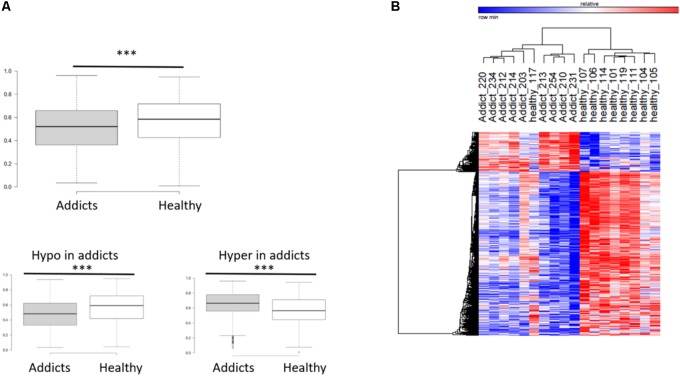
DNA methylation differences associated with addiction. (A) Box plot of average methylation of sites that are differentially methylated between addicted and healthy controls. Bottom panel: the average methylation of genes that become less methylated (hypomethylation) and more methylated (hypermethylation) in addicts ∗∗∗p < 2.2E-16; Mann–Whitney test. (B) Heat map showing clustering by one minus Pearson correlations of healthy controls and addicts using the 5,532 differentially methylated genes (4,458 probes were hypomethylated and 1,074 hypermethylated in addicts).